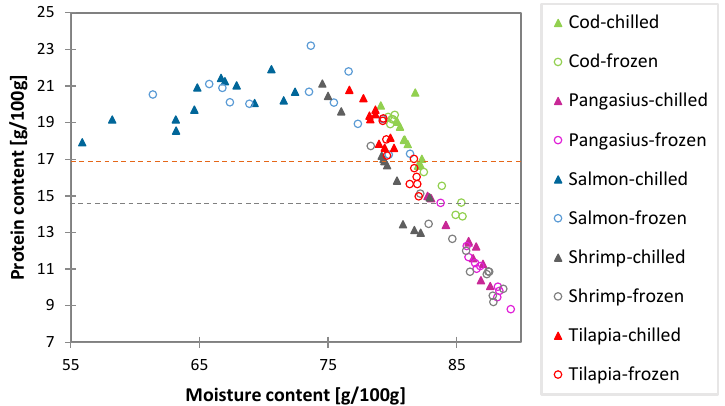
Figure 1. Moisture versus protein contents for individual samples of five seafood species (different colors), for both chilled (filled triangle) and frozen products (open circle). Horizontal lines indicate protein levels associated with minimal nitrogen factors for GMP (good manufacturing practice) fish ingredients for white fish (orange) and washed and peeled shrimp (grey)